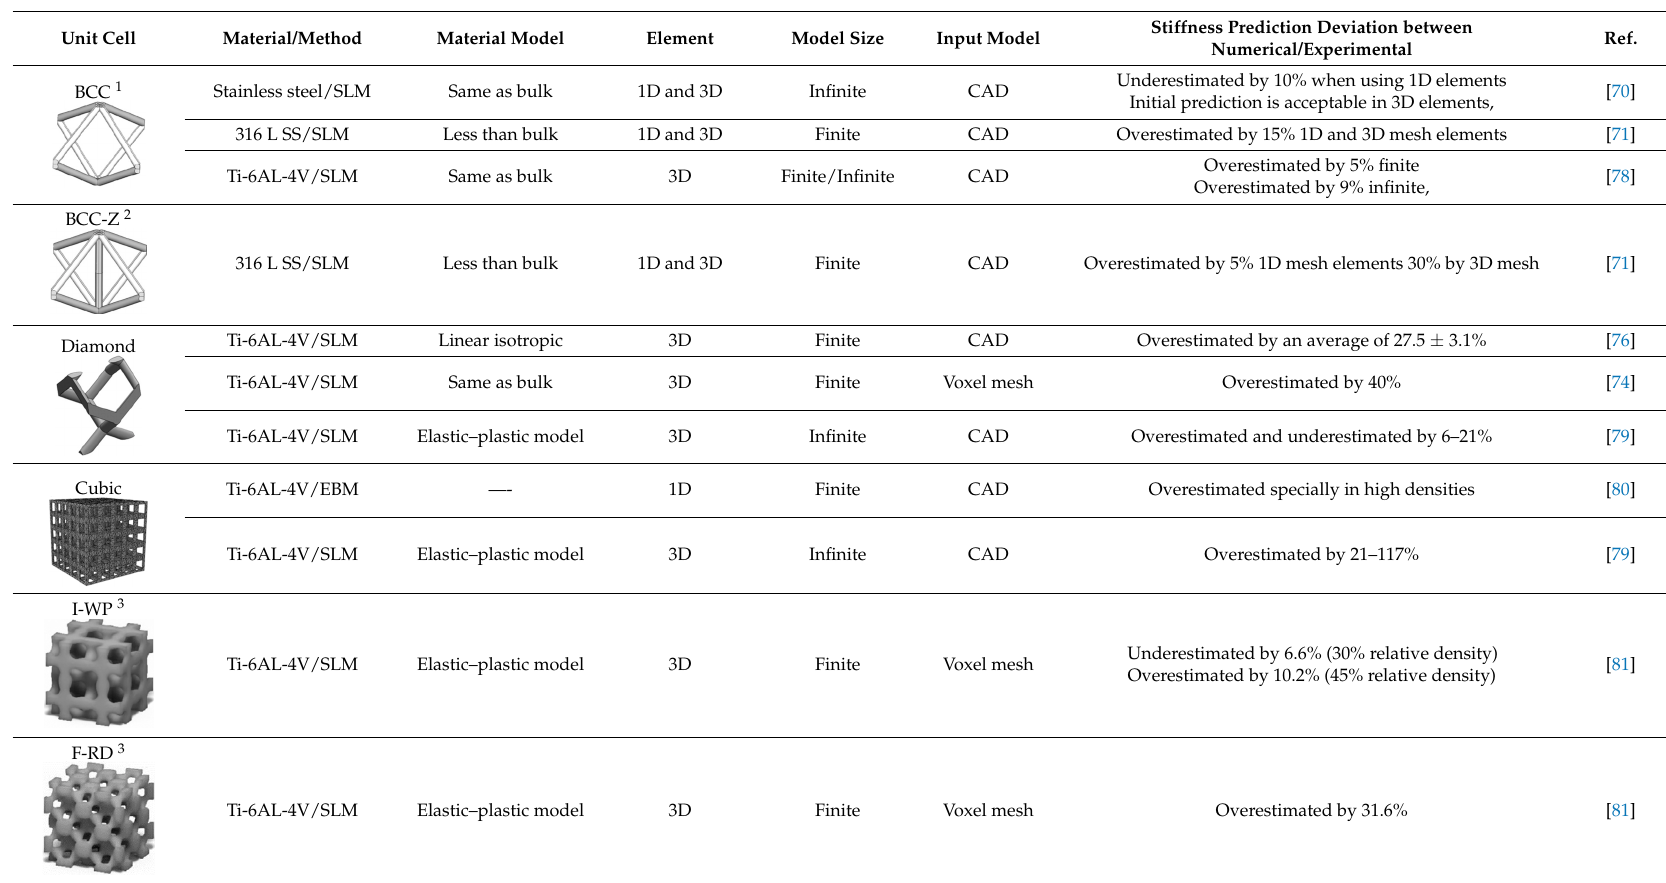
Table 2. Summary for the different finite element (FE) models used to predict mechanical properties of lattice structure.